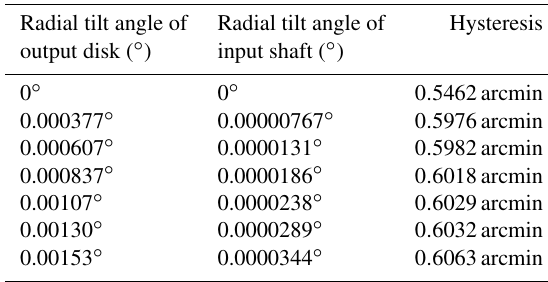
Table 10. Hysteresis within the range of different axial